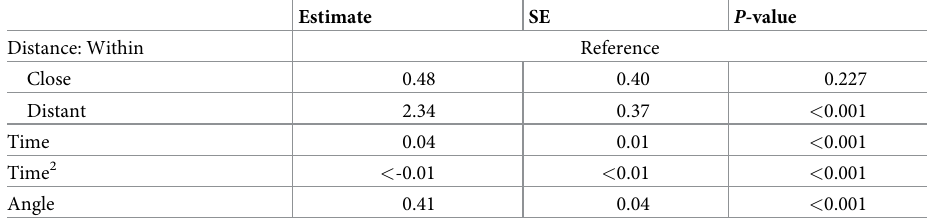
Table 4. Results of the random intercept and slope model.